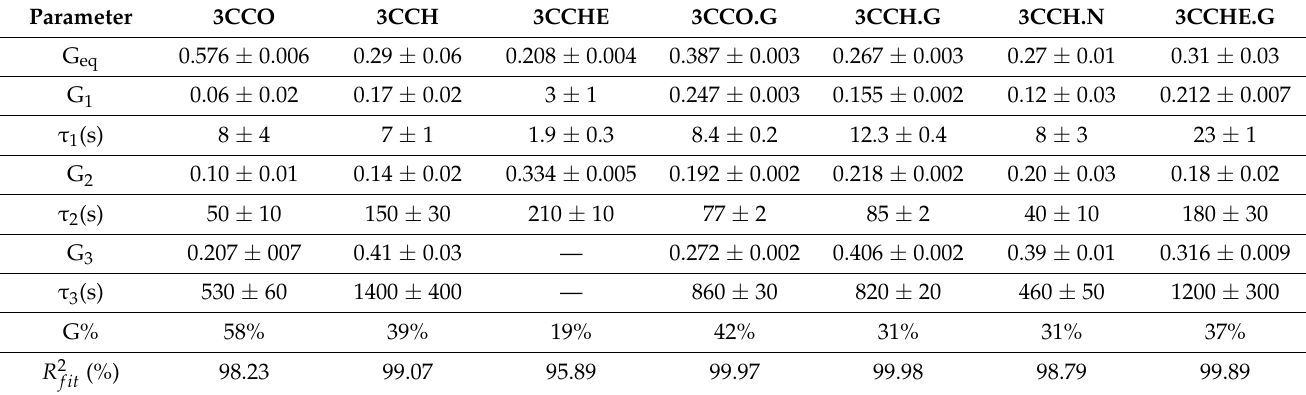
Table 4. Fitting parameters of the experimental data of Figure 5 to Equation (2) (mean ± SE). G% = (G(1800s)/G(5s)) × 100.